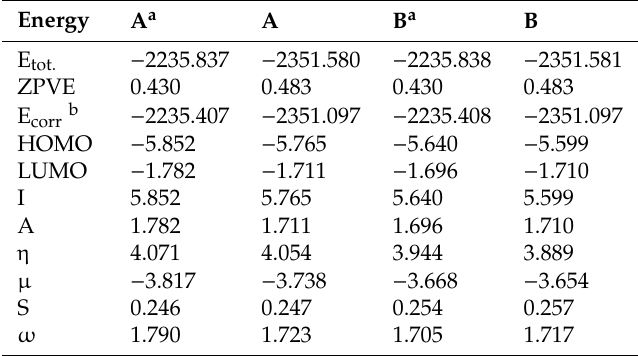
Table 3. Total energies (E tot. ), zero point energy correction (ZPVE) and the frontier molecular orbital energies of the studied